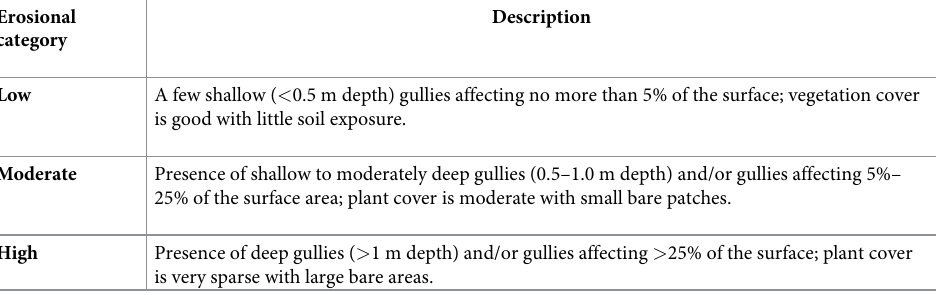
Table 1. Visual method used for estimating the degree of erosion of the studied hillslope seep wetland in the cur- rent study adopted from